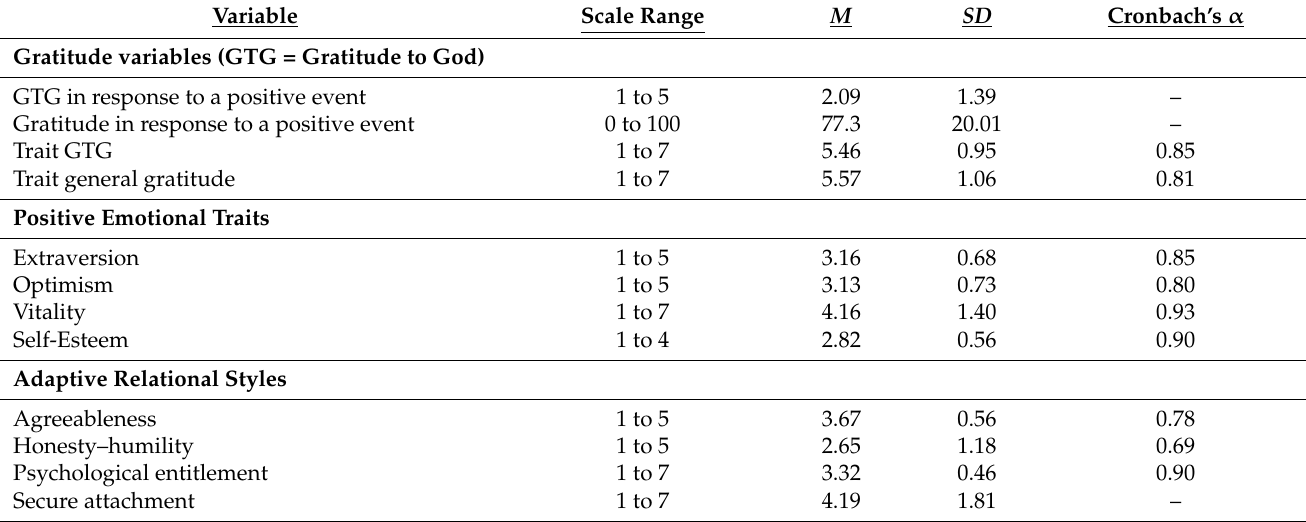
Table 1. Descriptive Statistics.